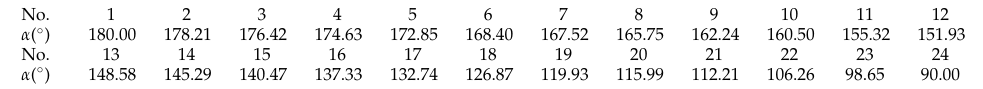
Figure 1. Schematic diagram of the relationship of the angle θ between k b1 / k b2 and x -axis and the angle α between the two sets of oblique crest lines: ( a ) Spatial graph of V-shaped undulating bottom ( α < 180 ◦ ); ( b ) Plane graph of V-shaped undulating bottom ( α < 180 ◦ ). The following parameters for the HOS numerical model are given referring to ref- erence [20]: the undulating bottom k b d = 0.31, where d and k b ( k b refers to k b1 and k b2 , and below is the same) are the amplitude and wavenumber of bottom undulations; the incident waves k 1 A = 0.05, where 2 A ≡ η max − η min , where A , k 1 , η max and η min are the amplitude, wavenumber, maximum elevation, and minimum elevation for surface wave of the incident regular waves respectively; relative water depth d / h = 0.16, where d and h are the amplitude of bottom and water depth; the total numbers of bottom undulations N b = L 0 / λ b = 10, where N b , L 0 , and λ b are the number, total length, and wavelength of the sinusoidal undulating bottom respectively; the time step for the fourth-order Runge–Kutta integration ∆ t ; the total simulation time T s ; running steps per period T / ∆ t = 64, where T is the period of the incident waves; the duration of the simulation periods T s / T = 20; node numbers N x × N y = 512 × 512; nonlinear order M = 3; V-shaped undulating bottom angle α = 90 ◦ –180 ◦ , where 24 values between 90 ◦ and 180 ◦ are distributed unevenly to the angle α of inclination for the V-shaped undulating bottom, as shown in Table 1. Table 1. The simulation cases of V-shaped undulating bottom angles α